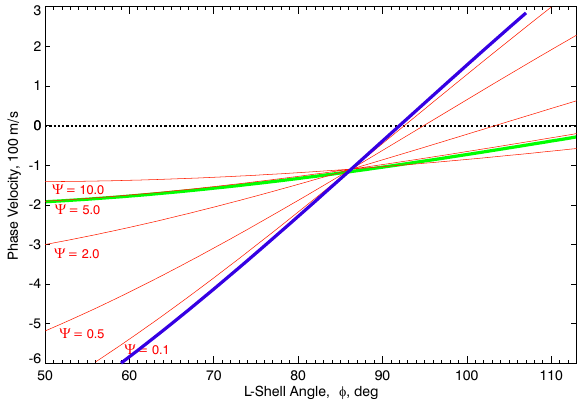
Fig. 6. Phase velocity versus L -shell angle. By the blue (green) line we show the fitted curve for F (E) region from Fig. 3. The predictions of the linear fluid theory calculated by assuming the ion drift V i 0 that is ten times smaller and rotated by 90 ◦ with respect to the electron drift V e 0 (which is estimated from the F- region velocity measurements, blue curve) and for anisotropy fac- tors 9 = 0 . 1 , 0 . 5 , 2 . 0 , 5 . 0, and 10.0 are shown by the red